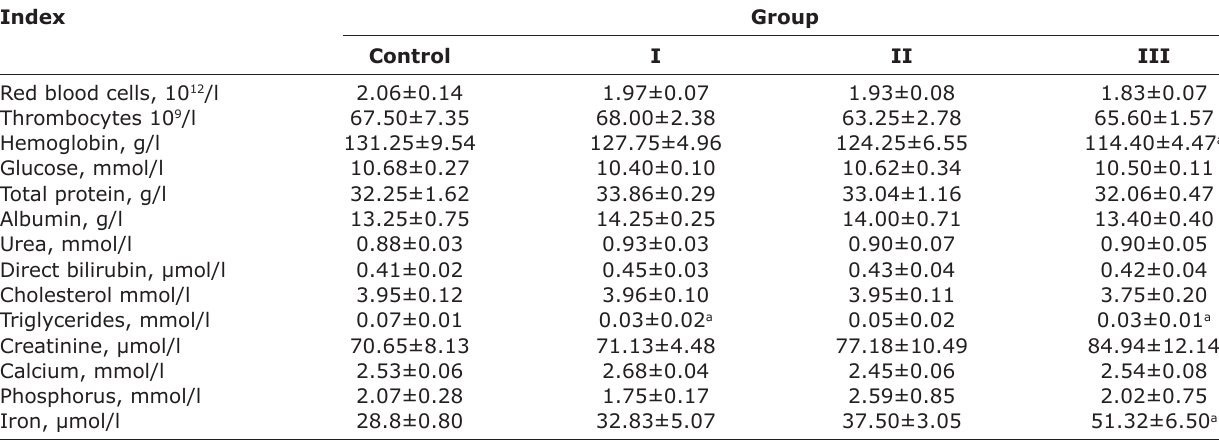
Table-2: Morphological and biochemical parameters of broiler chicken blood.